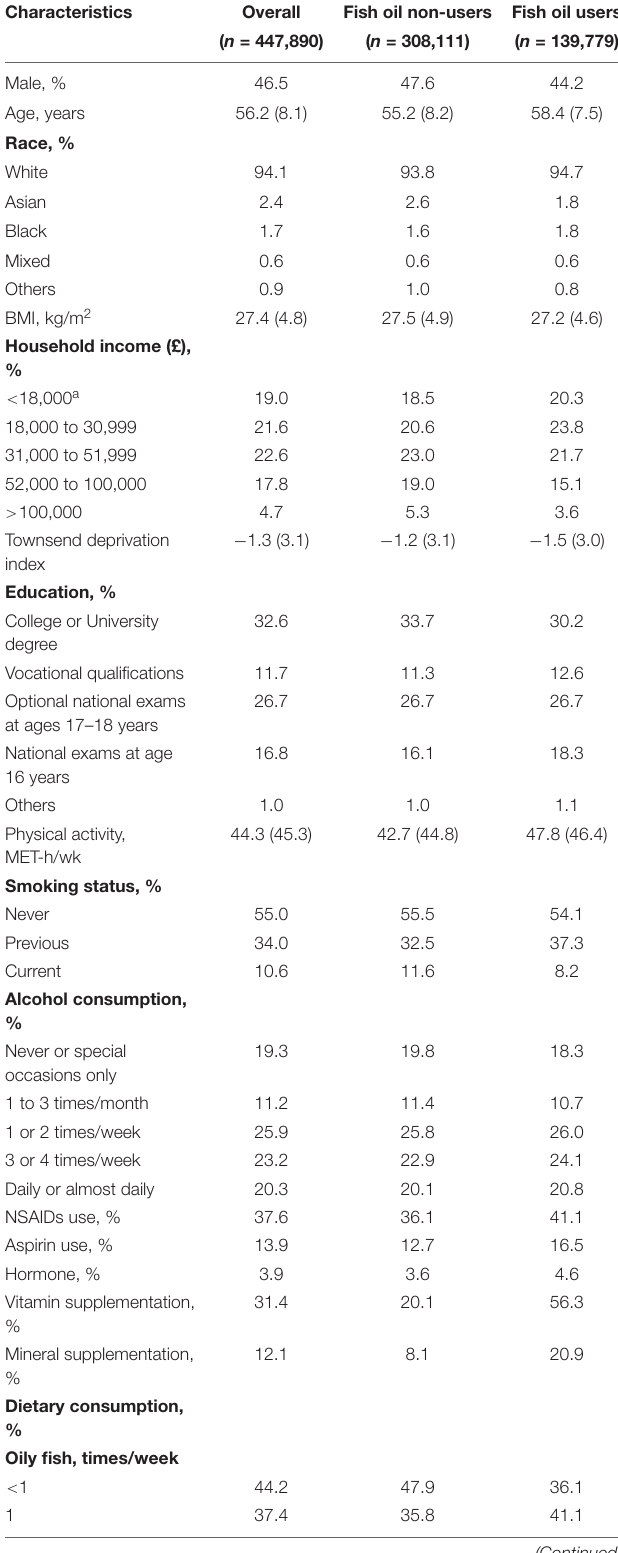
TABLE 1 | Basic characteristics of participants by use of fish oil in the UK Biobank cohort.